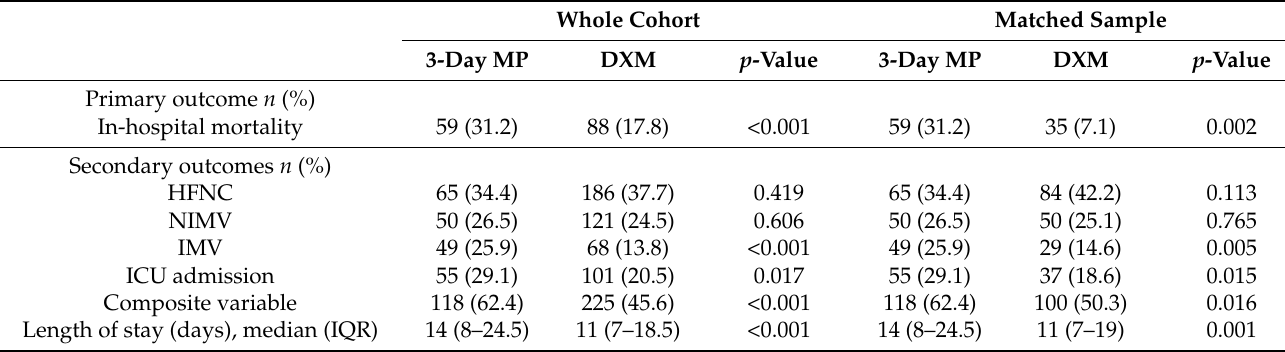
Table 5. Comparison of primary and secondary outcomes between groups.